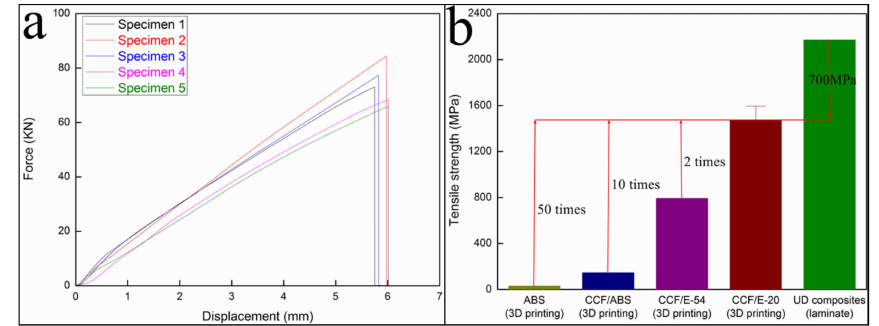
Figure 12. Tensile characterization: ( a ) the force–displacement curves and ( b ) tensile strengths of di ff erent materials.